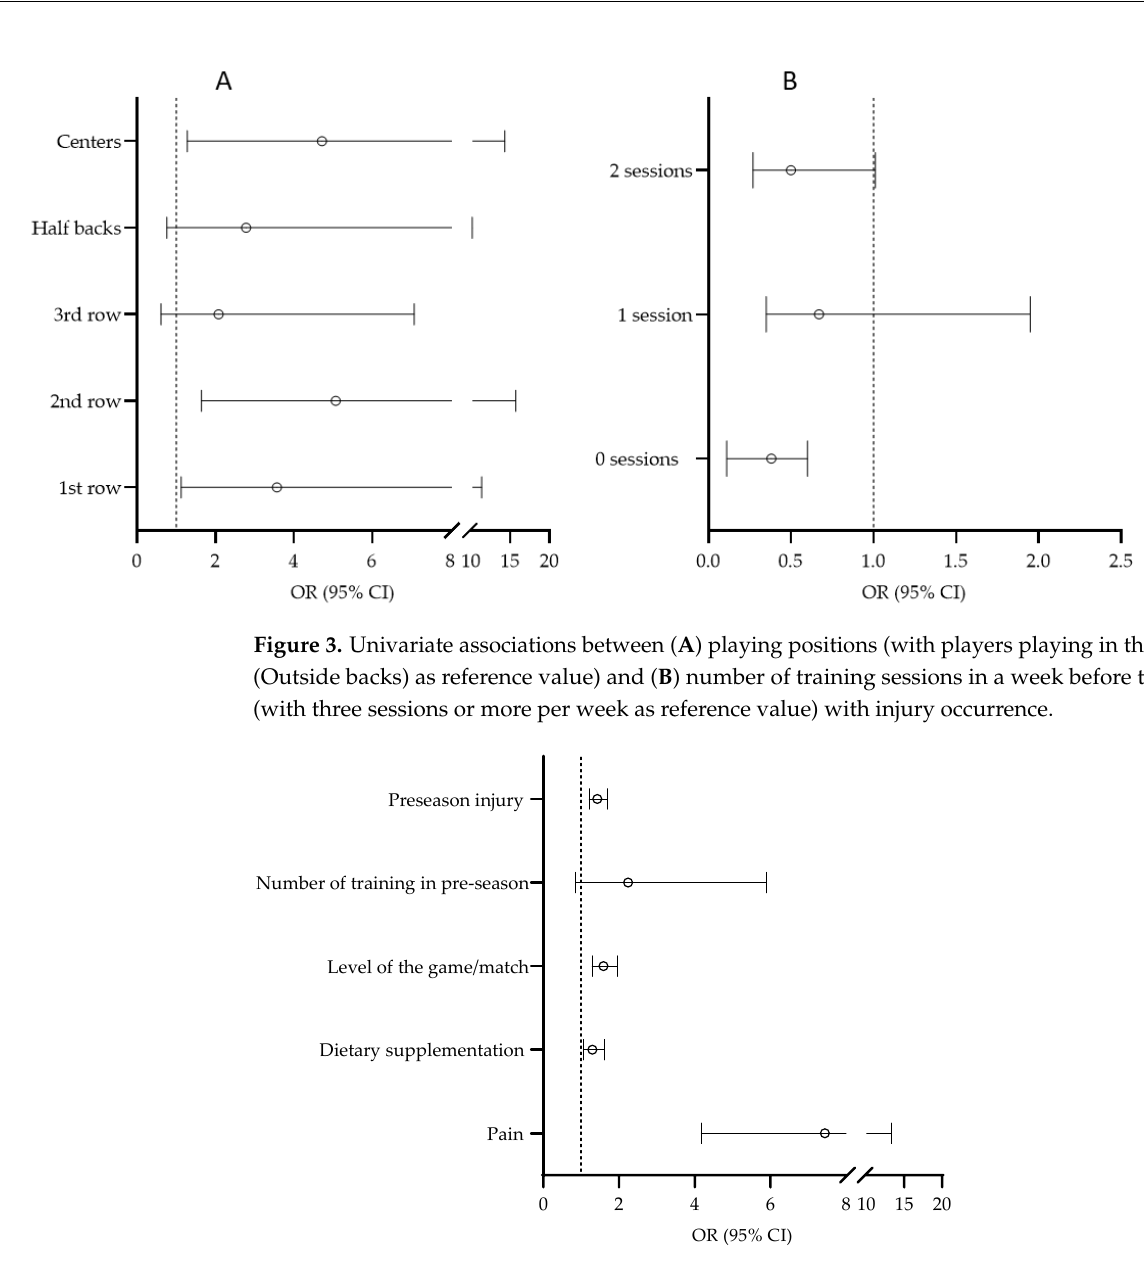
Figure 4. Univariate associations between preseason injury occurrence, preseason training, level of the game played, dietary supplementation, and pain prevalence with injury occurrence .